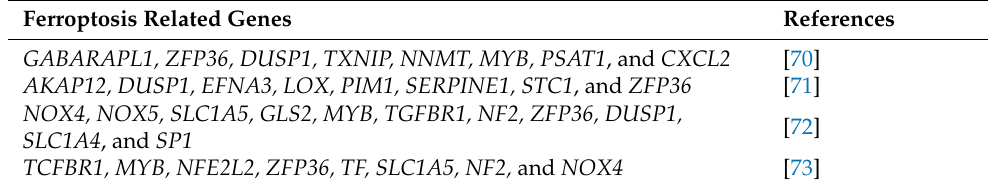
Table 2. Ferroptosis related genes used as diagnostic and prognostic markers in GC patients. Ferroptosis Related